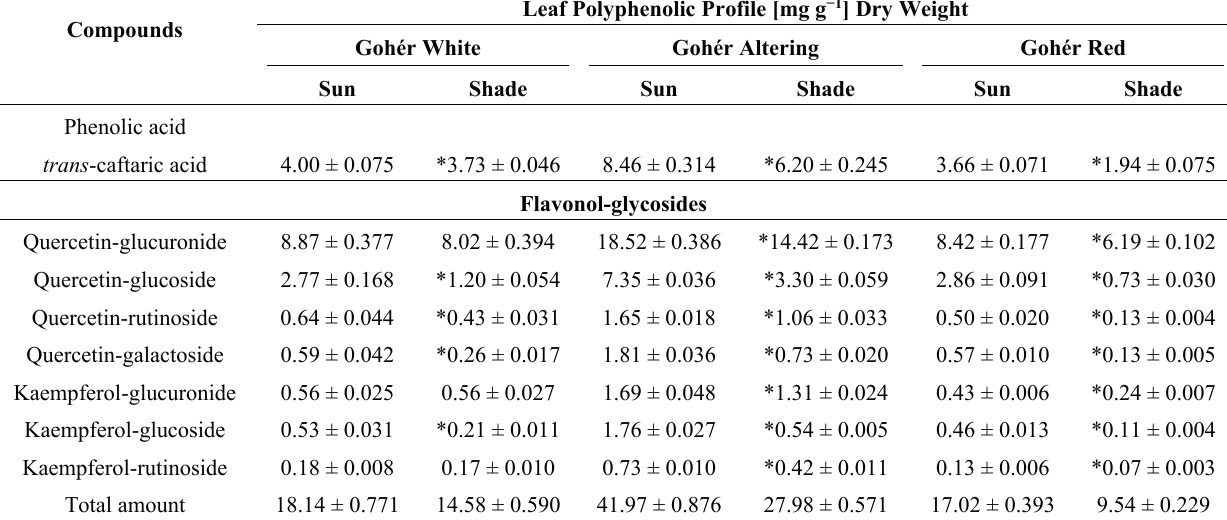
Table 1. Polyphenolic composition of sun and half shade leaves of Gohér varieties. Values are given as the average of three replicates ± SD. T-values from a paired Student’s- t -tests are in Table A2.